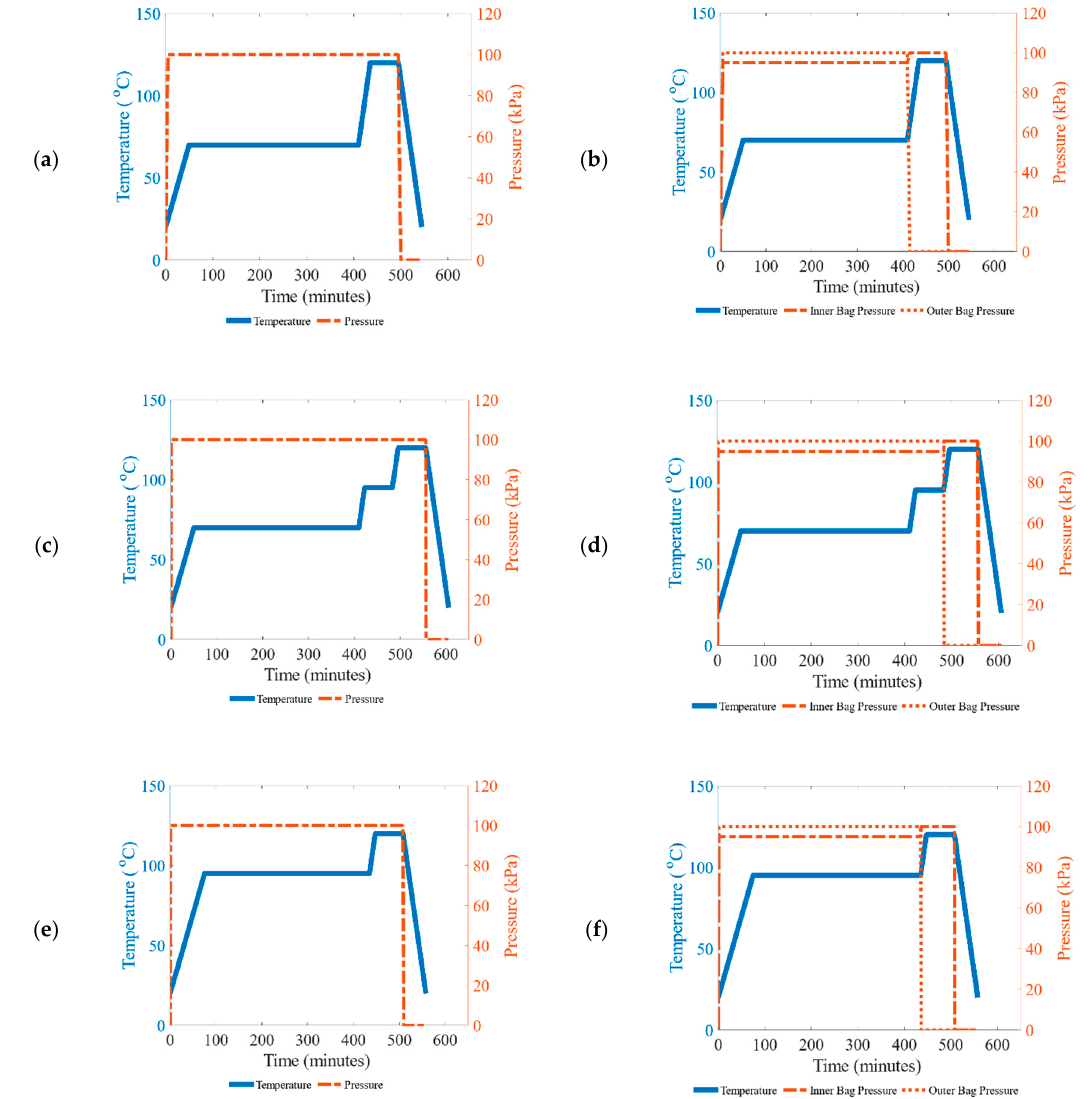
Figure 3. ( a ) MRCC for SVB and MSVB ( b ) MRCC for DVB ( c ) EMRCC for SVB and MSVB ( d ) EMRCC for DVB ( e ) DC for SVB and MSVB ( f ) DC for